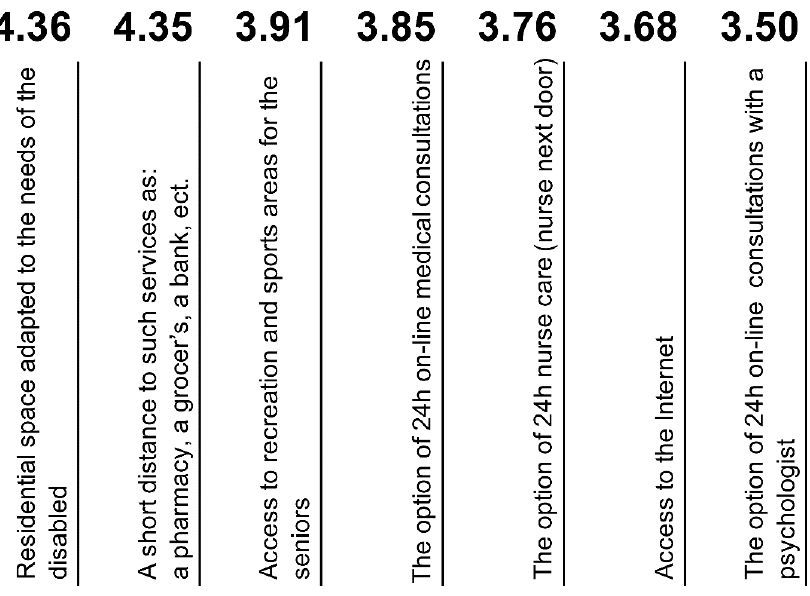
Figure 11. Evaluation of respective amenities for the seniors in their place of residence.